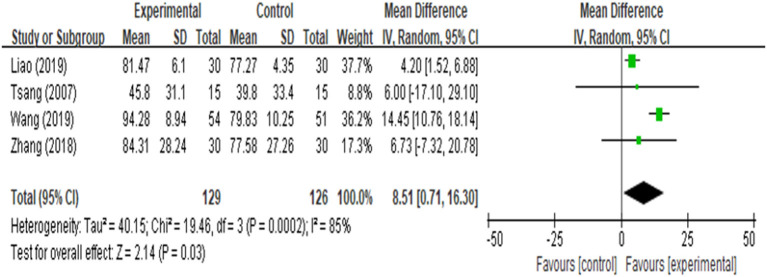
Meta-analysis and forest plot for function.